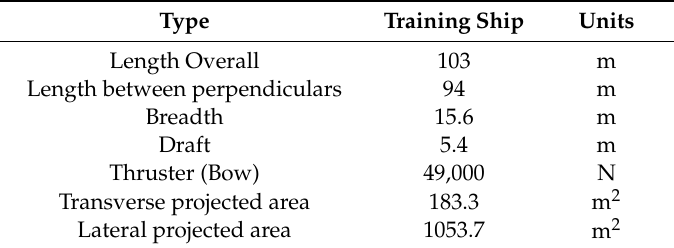
Table 1. Principle ship particulars.